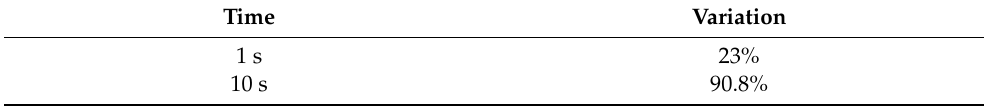
Table 2. Maximum variation in solar irradiance for decreasing